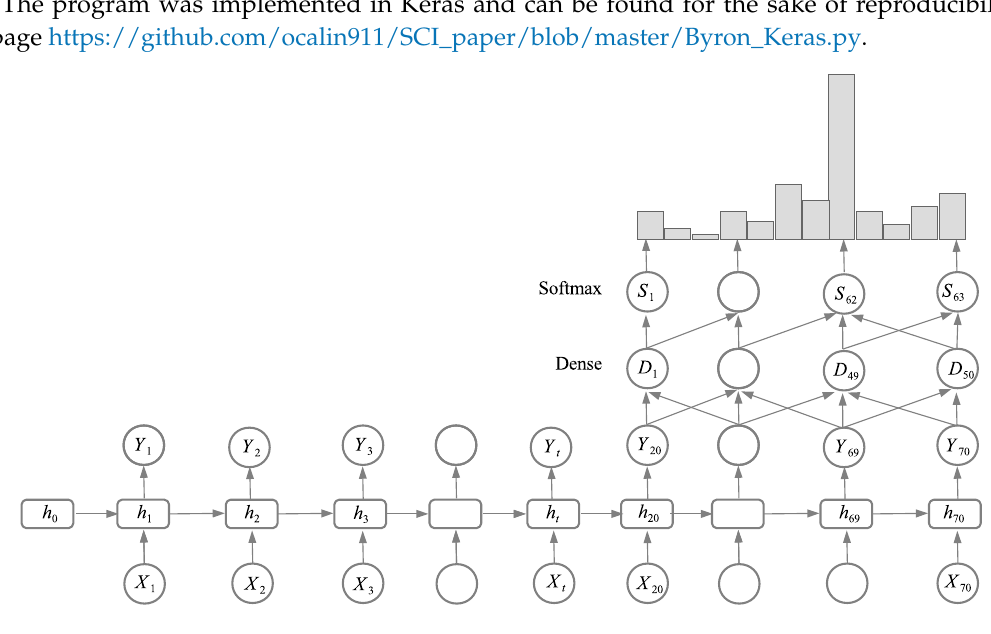
Figure 6. The characters present in Byron’s poetry. Each character is included between single quotation marks.